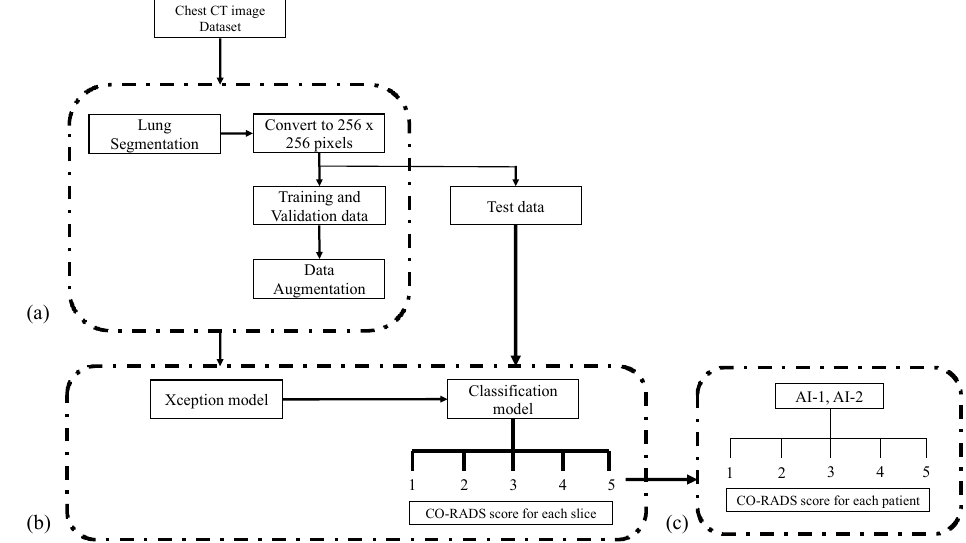
Figure 2. Classification workflow. ( a ) The collected chest CT DICOM images were subjected to lung segmentation using a workstation. The extracted lung fields were converted to images with 256 × 256 pixels and saved as PNG images, and the training images were augmented. ( b ) The augmented training images were subjected to the Xception model, and the test images were applied to the constructed artificial intelligence model to obtain the CO-RADS score for each slice. ( c ) The CO-RADS score for each patient was determined according to the defined method.